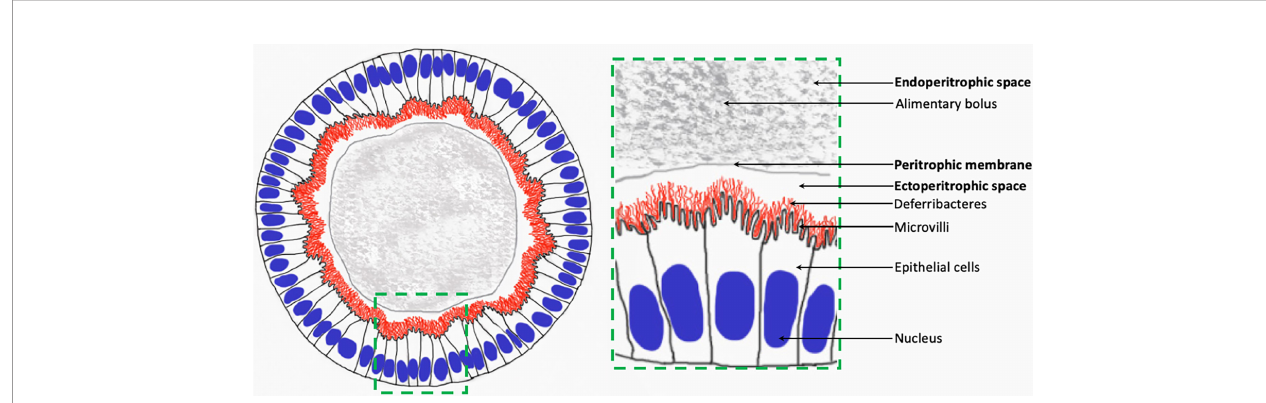
FIGURE 6 | Schematic view of Deferribacteres in adult Rimicaris spp. midgut